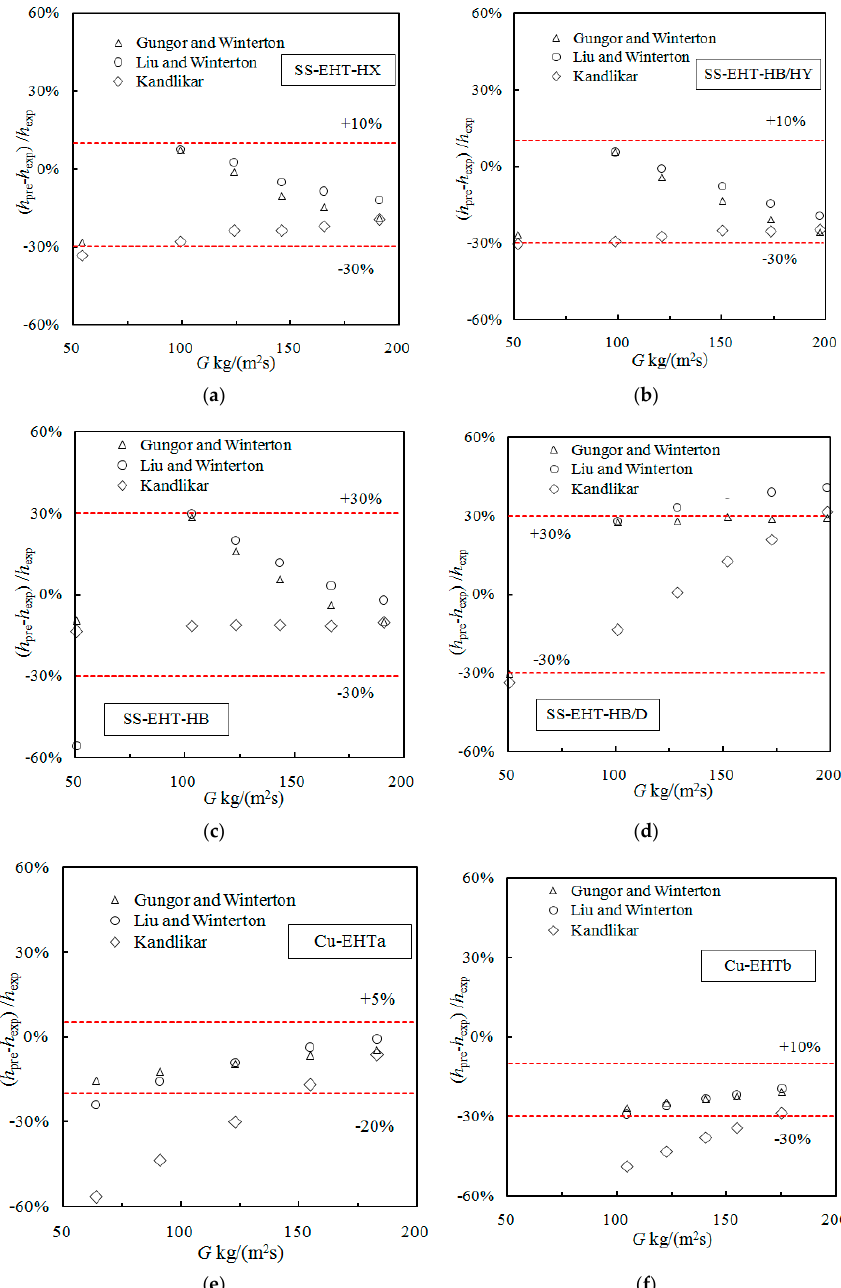
Figure 7. Comparison of the deviation of experimental data and values predicted using different smooth tube correlations for enhanced tubes. ( a ) Comparison of deviations of experimental data and values predicted using different correlations for SS-EHT-HX tubes; ( b ) Comparison of deviations of experimental data and values predicted using different correlations for SS-EHT-HB/HY tubes; ( c ) Comparison of deviations of experimental data and values predicted using different correlations for SS-EHT-HB tubes; ( d ) Comparison of deviations of experimental data and values predicted using different correlations for SS-EHT-HB/D tubes; ( e ) Comparison of deviations of experimental data and values predicted using different correlations for Cu-EHTa tubes; ( f ) Comparison of deviations of experimental data and values predicted using different correlations for Cu-EHTb